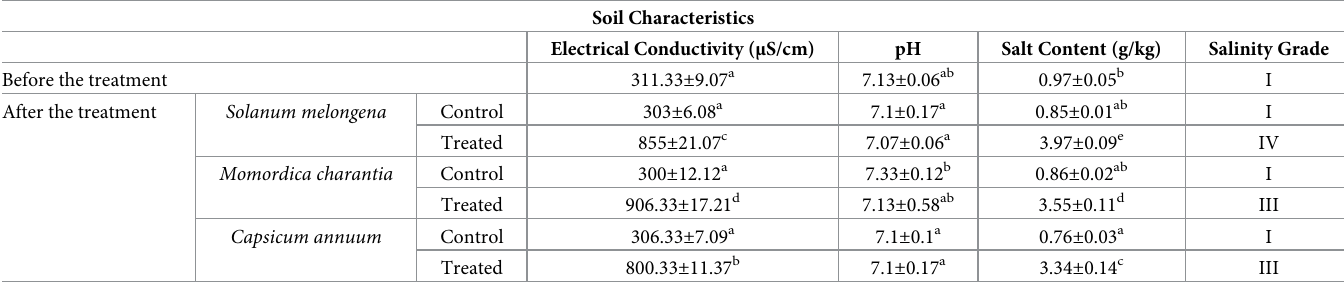
Table 2. Measurement results of soil characteristics.